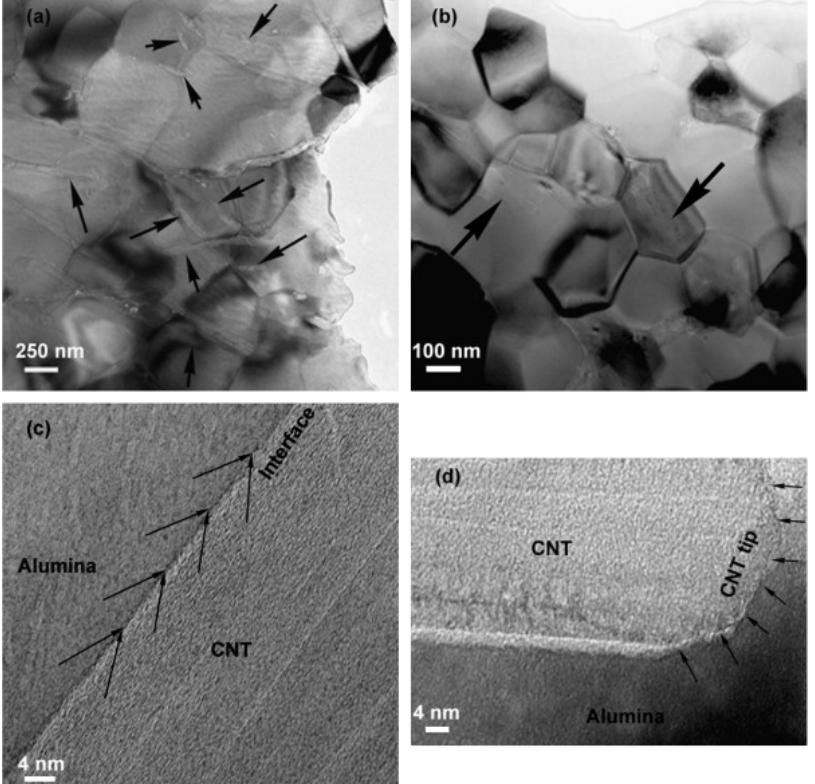
Figure 12. ( a ) and ( b ) FESEM micrographs; ( c ) and ( d ) TEM micrographs of fracture surface of as-consolidated 3.5 vol% CNT reinforced Al arrows in ( a ) and ( b ) indicate CNTs